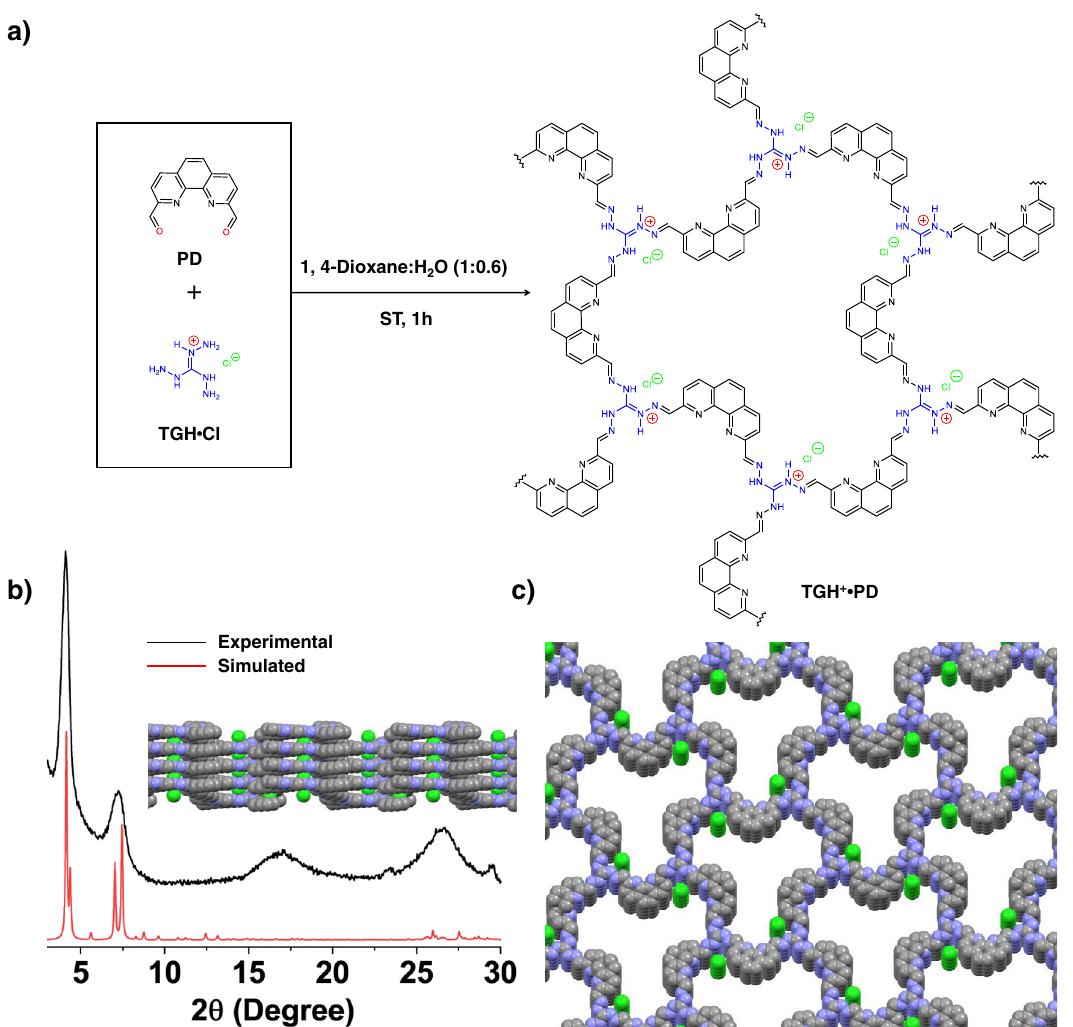
Fig. 1 Synthetic strategy for the preparation of iCOF materials. a Synthesis and chemical structure of TGH + (cid:129) PD obtained under solvothermal (ST) conditions at 120 °C from a 1:0.6 (v : v) 1,4-dioxane:H 2 O mixed solvent. b Structural characterization of TGH + (cid:129) PD showing comparison between the experimental powder X-ray diffraction (PXRD) pattern of TGH + (cid:129) PD and the simulated PXRD pattern of the AA stacking model (shown inset). c Top view of a space- fi lling representation containing four stacked layers of TGH + (cid:129)